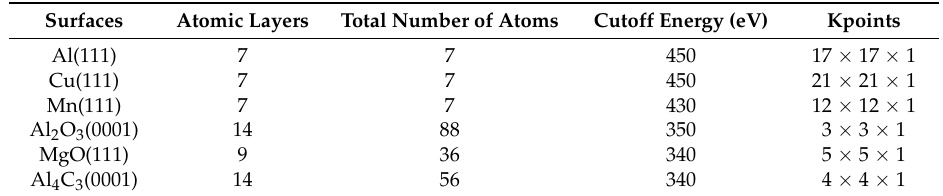
Table 3. Atomic layers, total number of atoms, cutoff energy and Kpoints of Al(111), Cu(111), Mn(111),